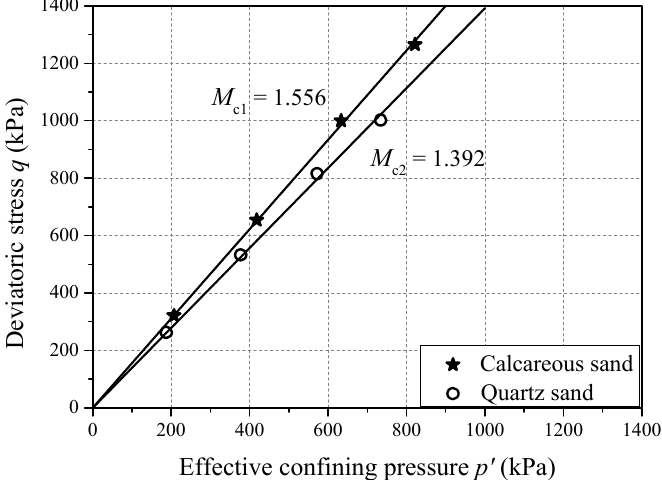
Figure 5. The critical state lines in the q – p ′ plane of the calcareous sand and quartz sand ( D m = 2.667).